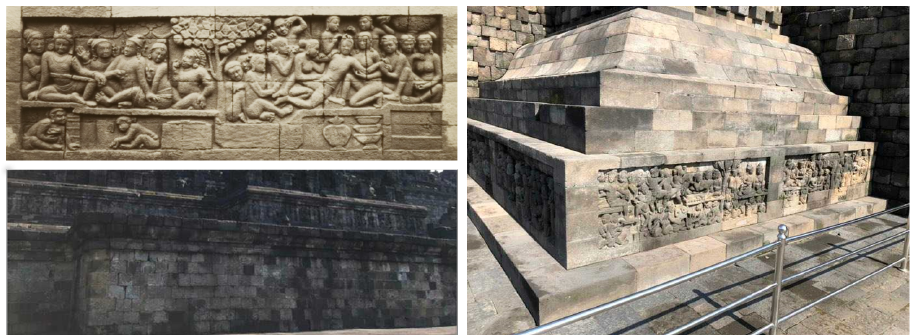
Figure 9. The example of the old photo ( left top ), the stone wall covering the hidden reliefs ( left, bottom ), and the southeast corner with the remaining four “Karmawibhangga” reliefs ( right